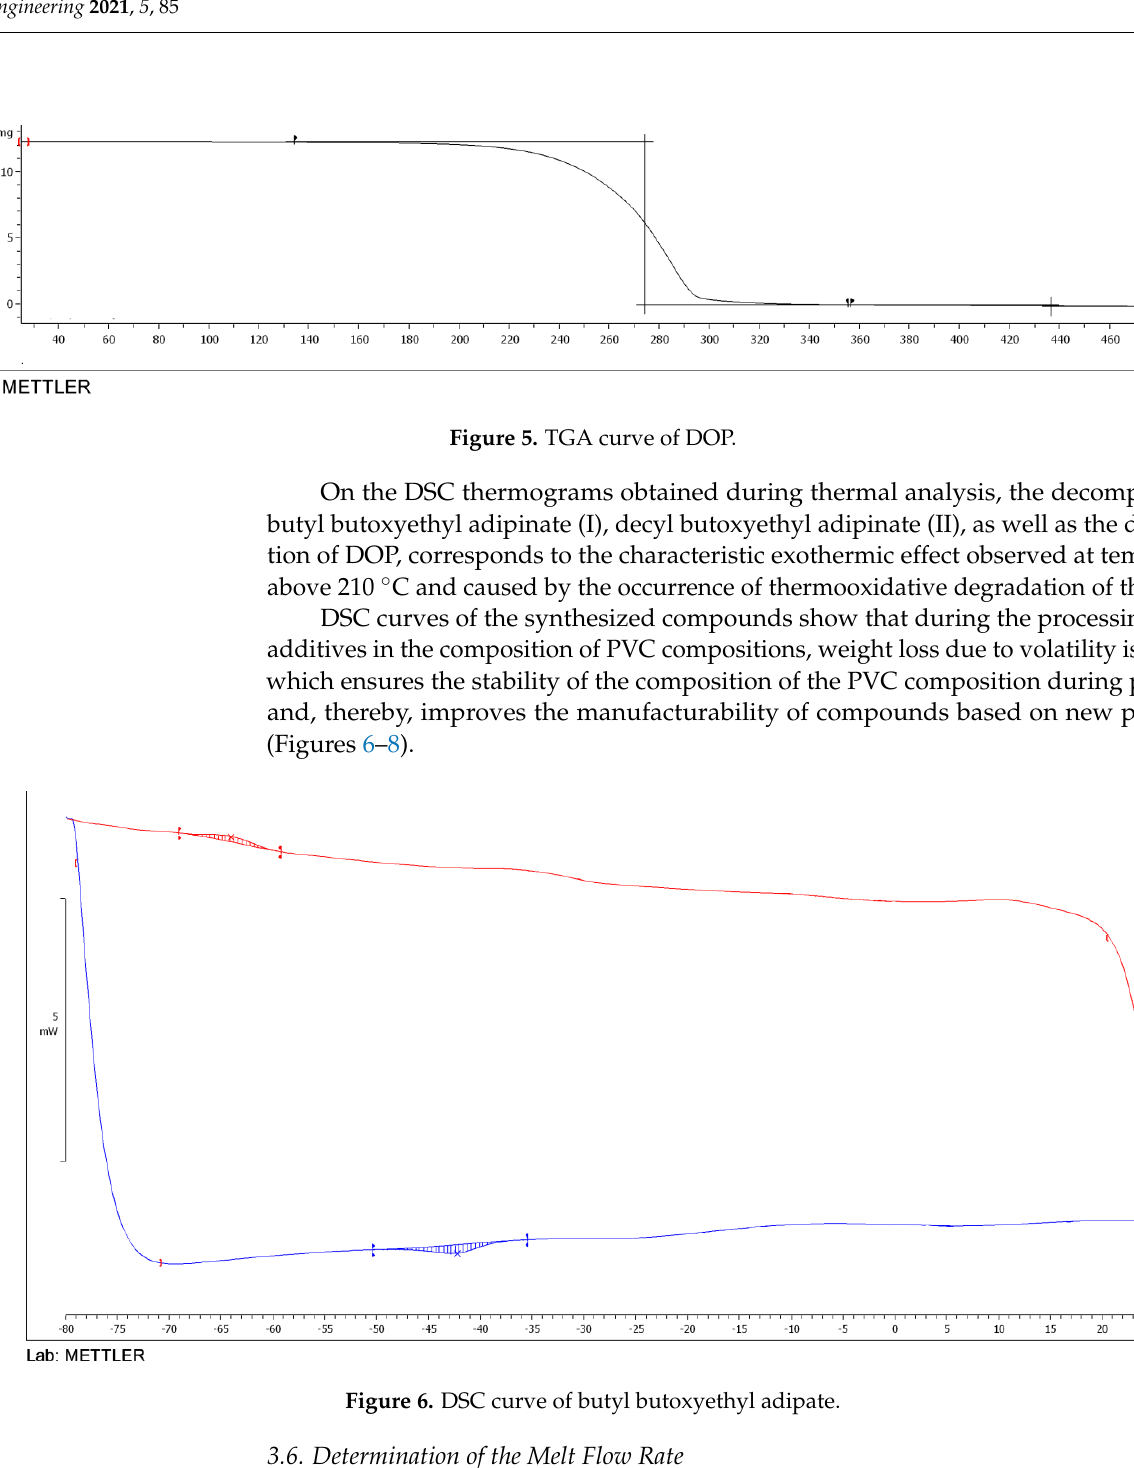
Figure 4. TGA curve of decyl butoxyethyl adipate.